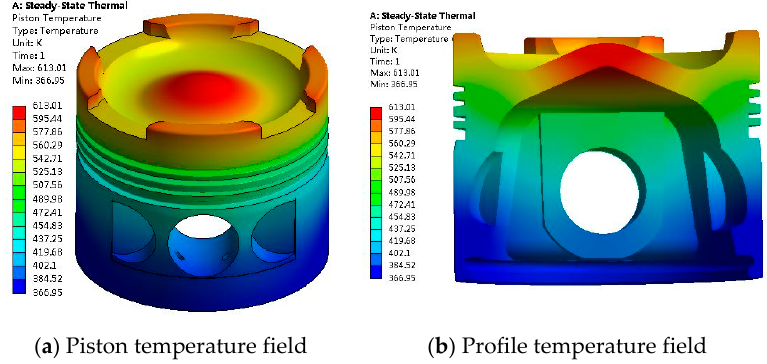
Figure 1. Detailed temperature field of the piston. ( a ) Piston temperature field; ( b ) Profile temperature field.